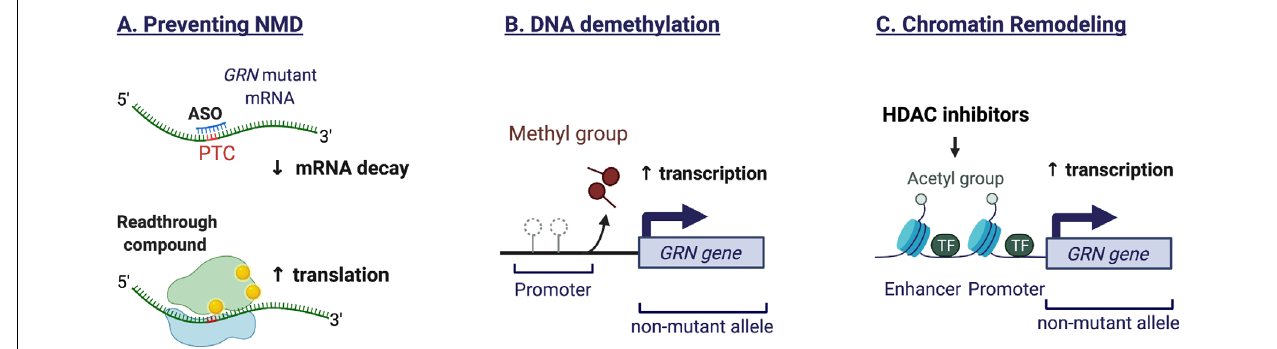
FIGURE 3 | Mechanisms to increase endogenous GRN expression. (A) The majority of GRN mutations are nonsense and frameshift mutations that introduce premature termination codons (PTC). The presence of a PTC triggers the nonsense-mediated mRNA decay (NMD) machinery, resulting in degradation of the aberrant transcript and preventing protein translation. Antisense oligonucleotides (ASO) can stabilize the mutant mRNA by preventing the recruitment of NMD proteins. Alternatively, readthrough compounds can suppress nonsense mutations, leading to increased mRNA stability and protein translation. The efficacy of these approaches is mutation-dependent. (B) Epigenetic mechanisms regulate the expression of GRN from the healthy allele. GRN promotor demethylation promotes transcription. (C) Histone acetylation favors an open chromatin structure that is more permissive to gene transcription. HDAC inhibitors can prevent histone deacetylation and therefore increase GRN expression.